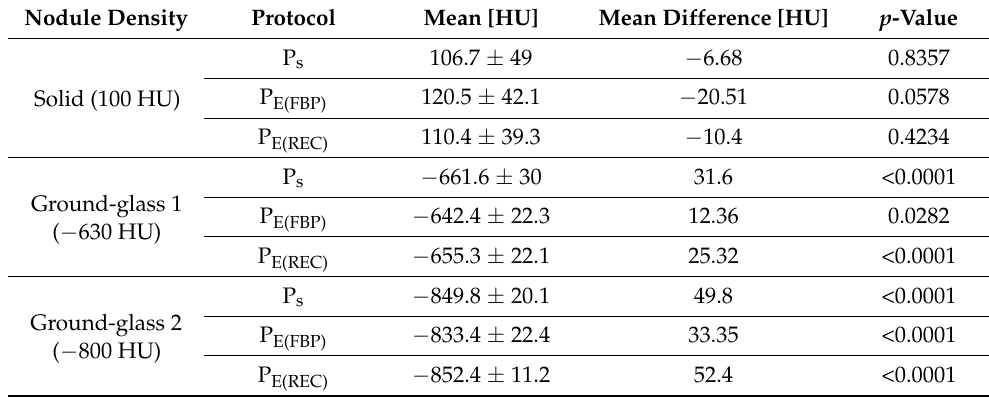
Table 3. Mean difference of attenuated and objective nodule densities. The table above displays the mean, mean difference and p -value of each protocol compared to the genuine nodule density (HU, Hounsfield Units). Institute-specific standard low-dose protocols (P S ) and ESTI protocols (P E ) reconstructed with filtered back projection (P E(FBP) ) as well as with iterative reconstruction (P E(REC) ) were